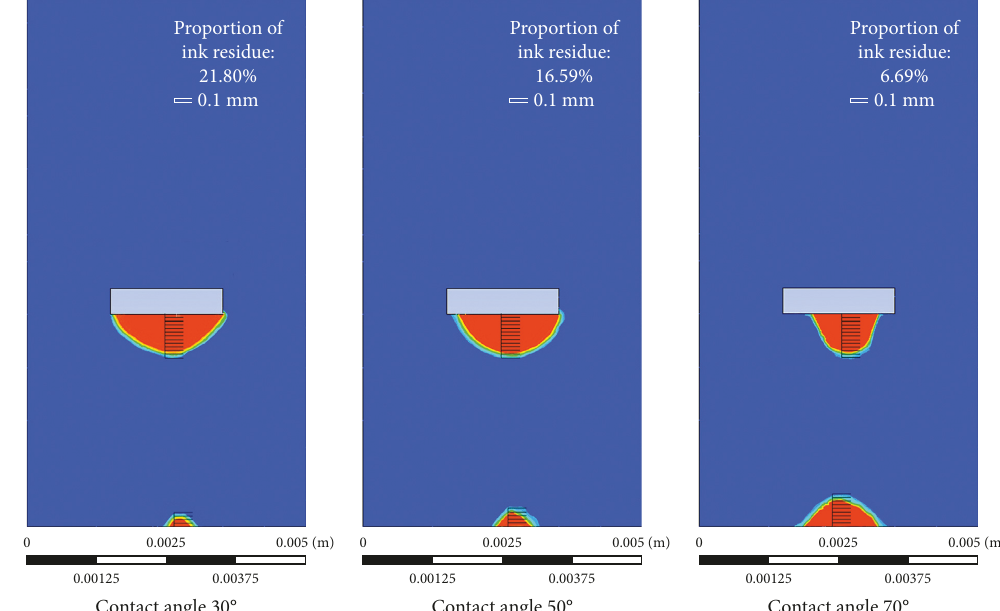
Figure 11: Cloud picture of numerical simulation of ink residue.